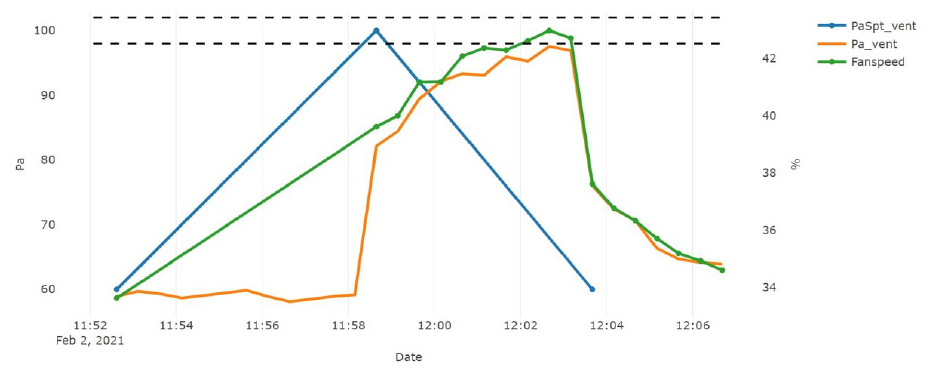
Figure 14. Time step response of the ventilation setup: short